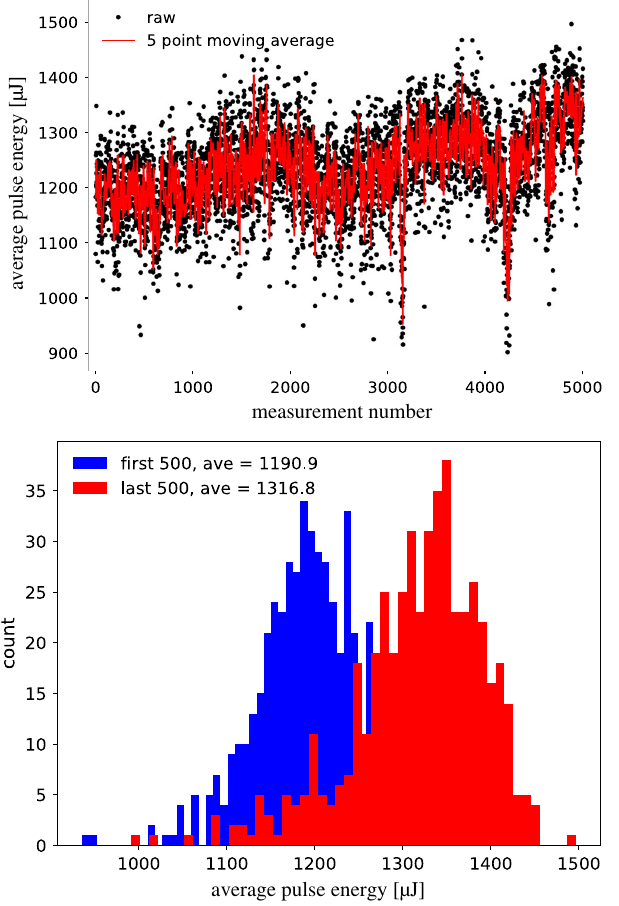
FIG. 4. Average bunch energy is increased despite large random jumps and extremely high variance of the noisy signal.